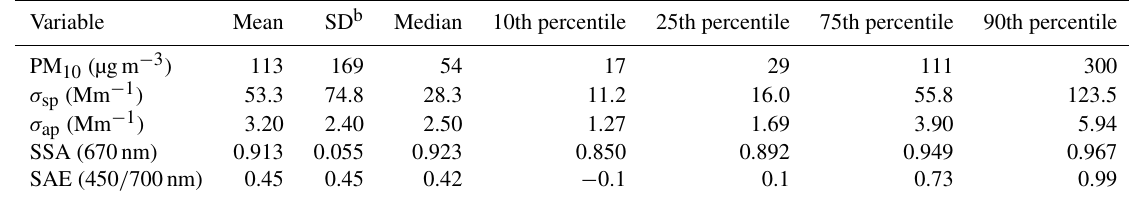
Table 2. Statistical summary of hourly-averaged aerosol optical properties measured during an intensive observation period a . Variable